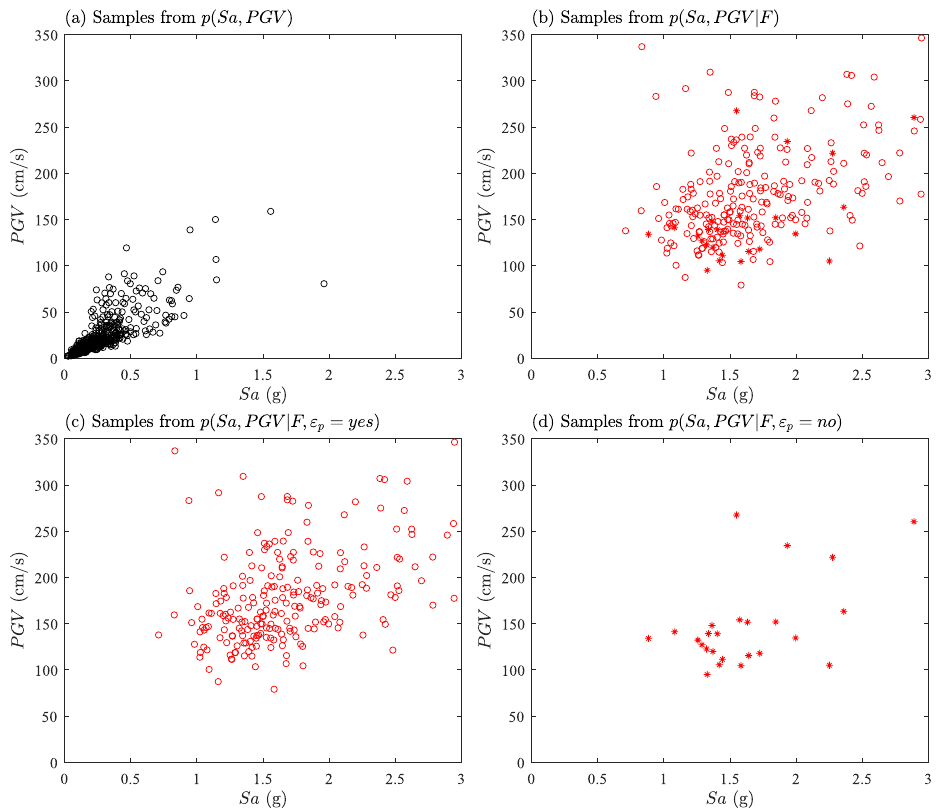
Figure 14. Samples from ( a ) p ( Sa , PGV ) , ( b ) p ( Sa , PGV | F ) , ( c ) p ( Sa , PGV | F , ε p = yes ) , and ( d ) p ( Sa , PGV | F , ε p = no ) . All the plots are for chevron-braced